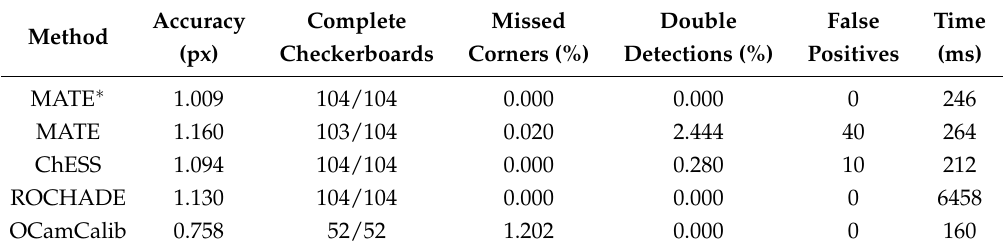
Table 1. Results on the training set P clean .